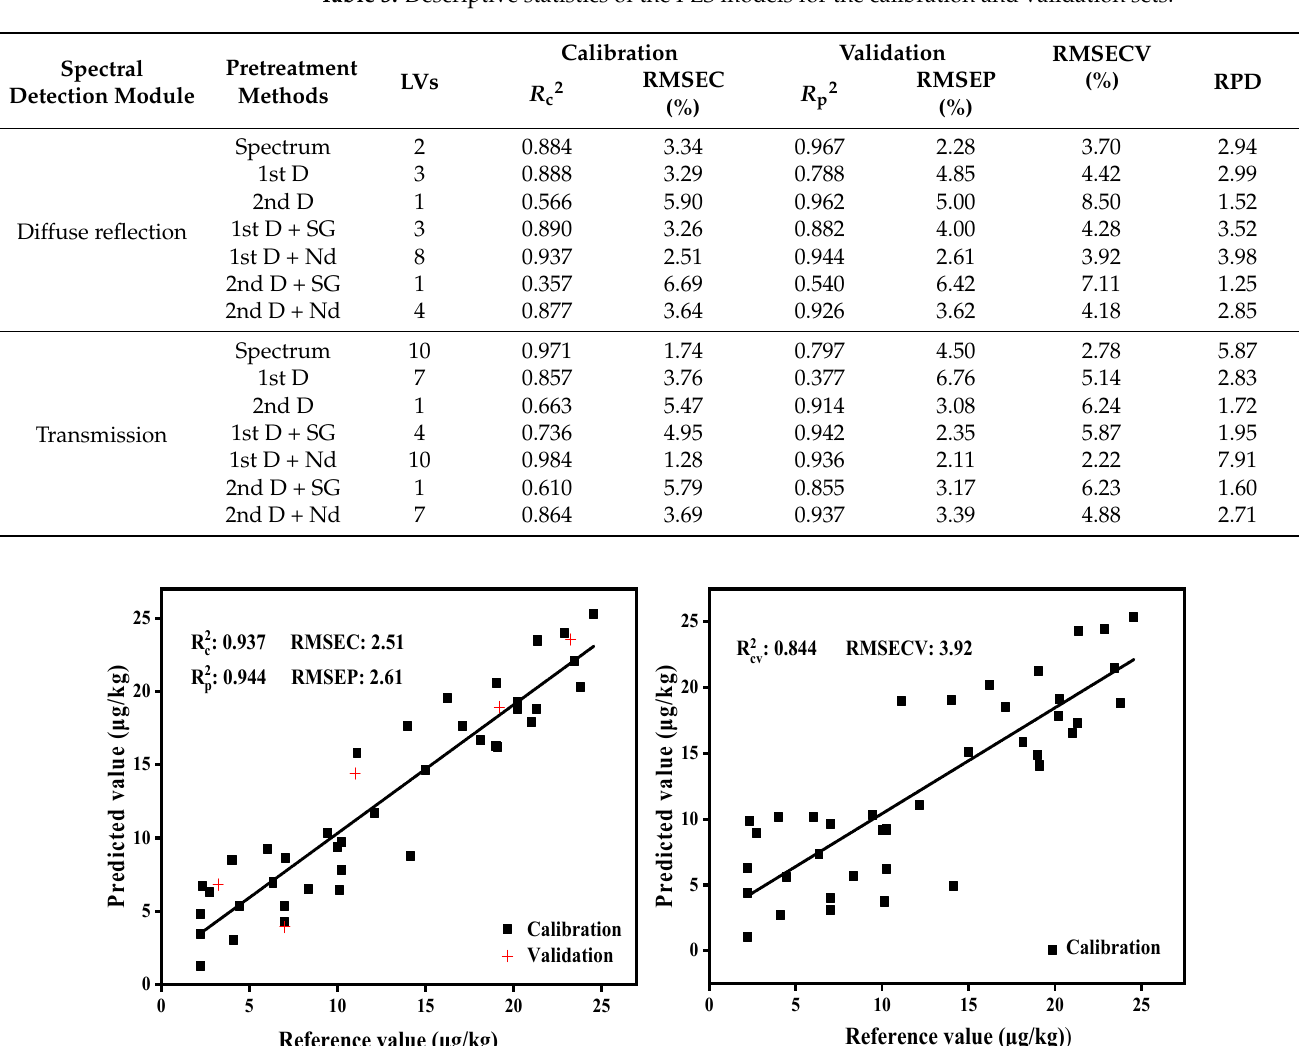
Figure 10. PLS model and cross-validation of the diffuse reflection module.